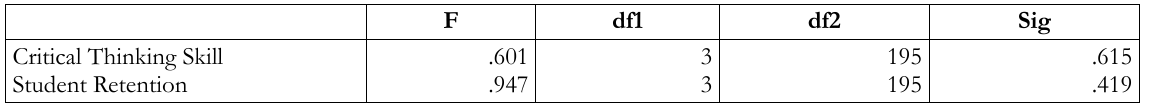
Table 10. Levene’s Test of Equality of Error